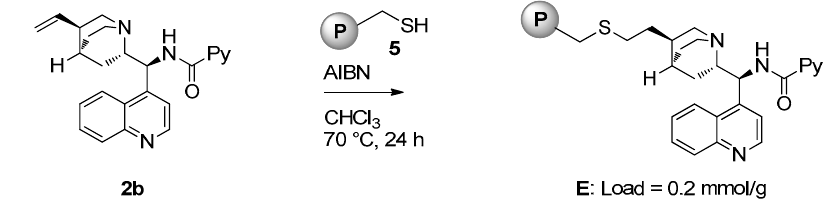
Figure 4. Synthesis of polystyrene-supported catalyst E .